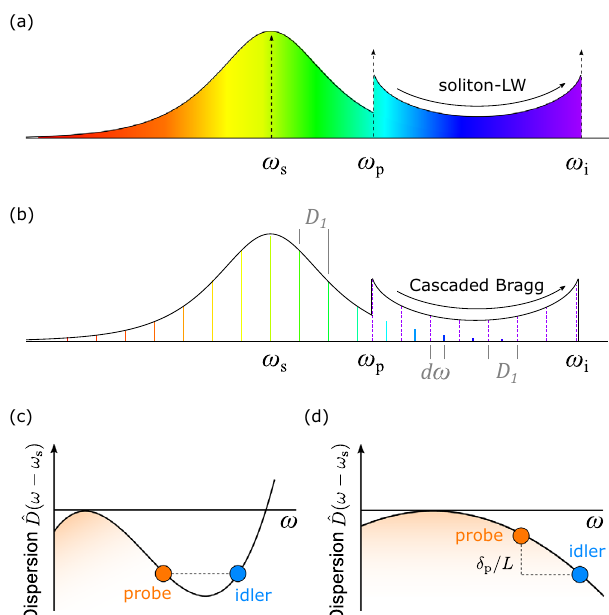
Fig. 1 Soliton-linear wave scattering. a Schematic illustration of the interaction between a soliton at ω s and a weak linear wave (LW) at ω p . The interaction enables the fl ow of energy to a phase-matched idler wave at ω i . b Frequency domain description of the soliton-linear wave interaction in ( a ), showing how the energy fl ow can be described as a cascade of nonlinear Bragg-scattering events. Components of the newly-generated idler comb are all shown in purple for clarity. The idler comb possesses the same free spectral range = D 1 /(2 π ) but is offset from the soliton comb (by d ω ). c , d visualize the phasematching of the process in single-pass and resonator con fi gurations, respectively. c In single-pass con fi gurations, higher-order dispersion is required for phasematching. d The extra degree of freedom provided by the probe detuning δ p relaxes the phasematching condition in